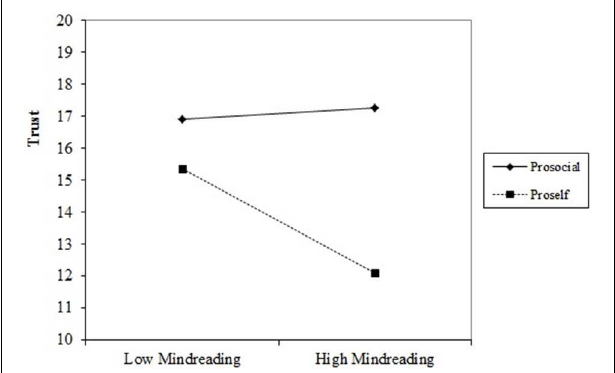
FIGURE 1 | Plots of slopes for the interaction between mindreading and social value orientation (prosocial or proself) on trust, using sex and age as control variables. In the Plot, low mindreading is set at − 1 standard deviation from the mean and high mindreading at + 1 standard